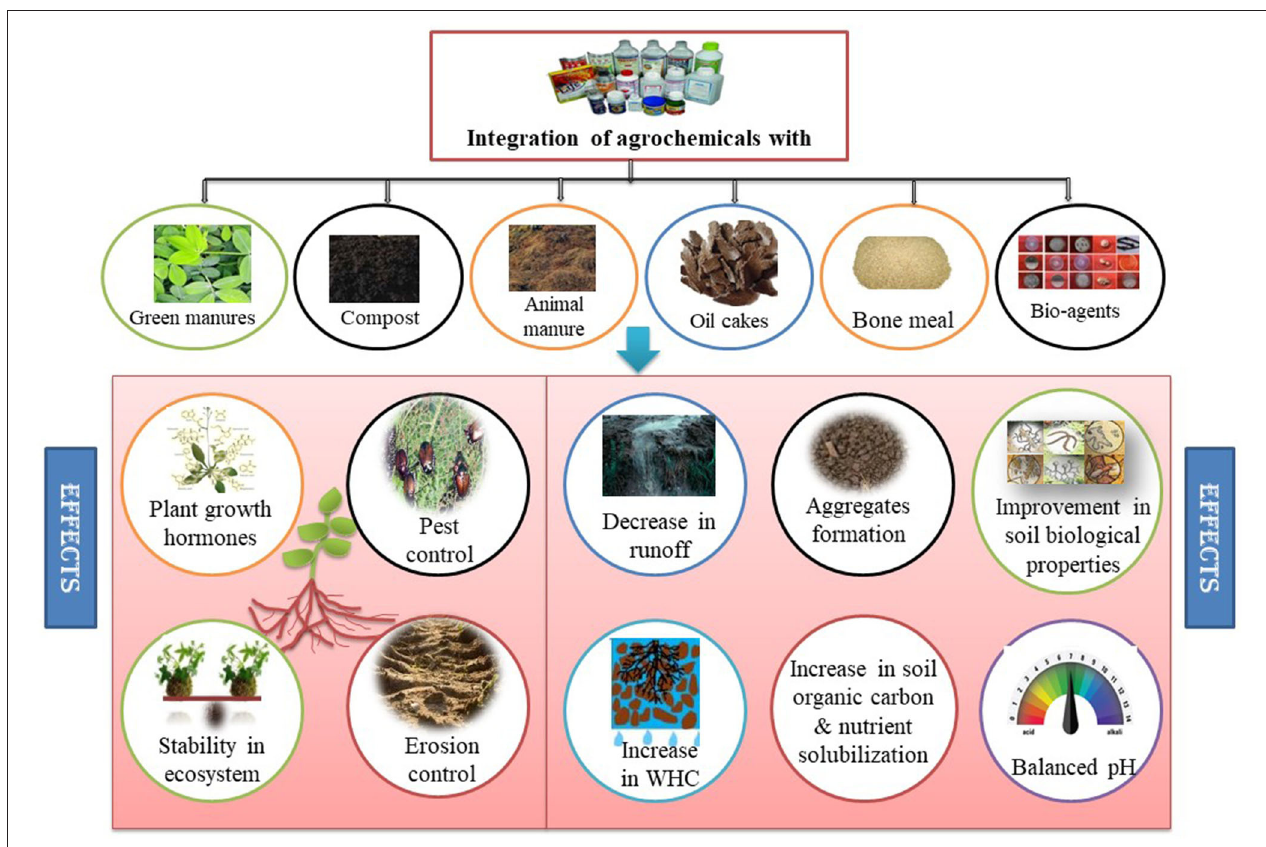
FIGURE 1 | Benefits of integrating agrochemicals with natural